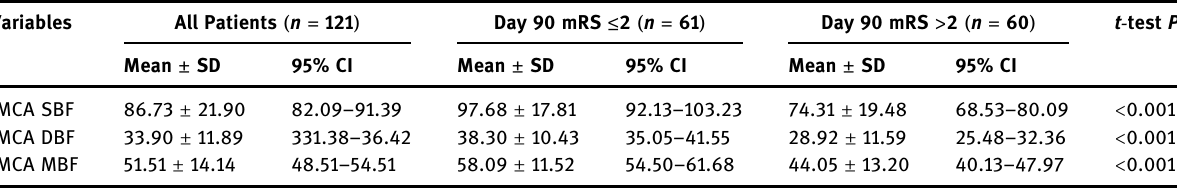
Table 2: Postinterventional transcranial duplex sonography fi ndings in patients with di ff erent 90 - day mRS scores treated by mechanical thrombectomy